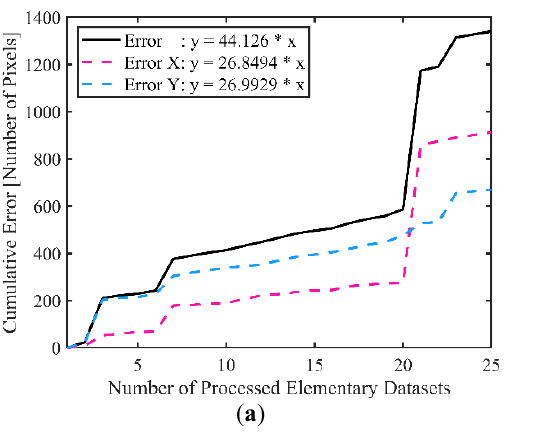
Figure 7. Cumulative repositioning errors with two different stitching algorithms: one has failed ( a ) and the other has succeeded in stitching ( b ) the elementary maps.